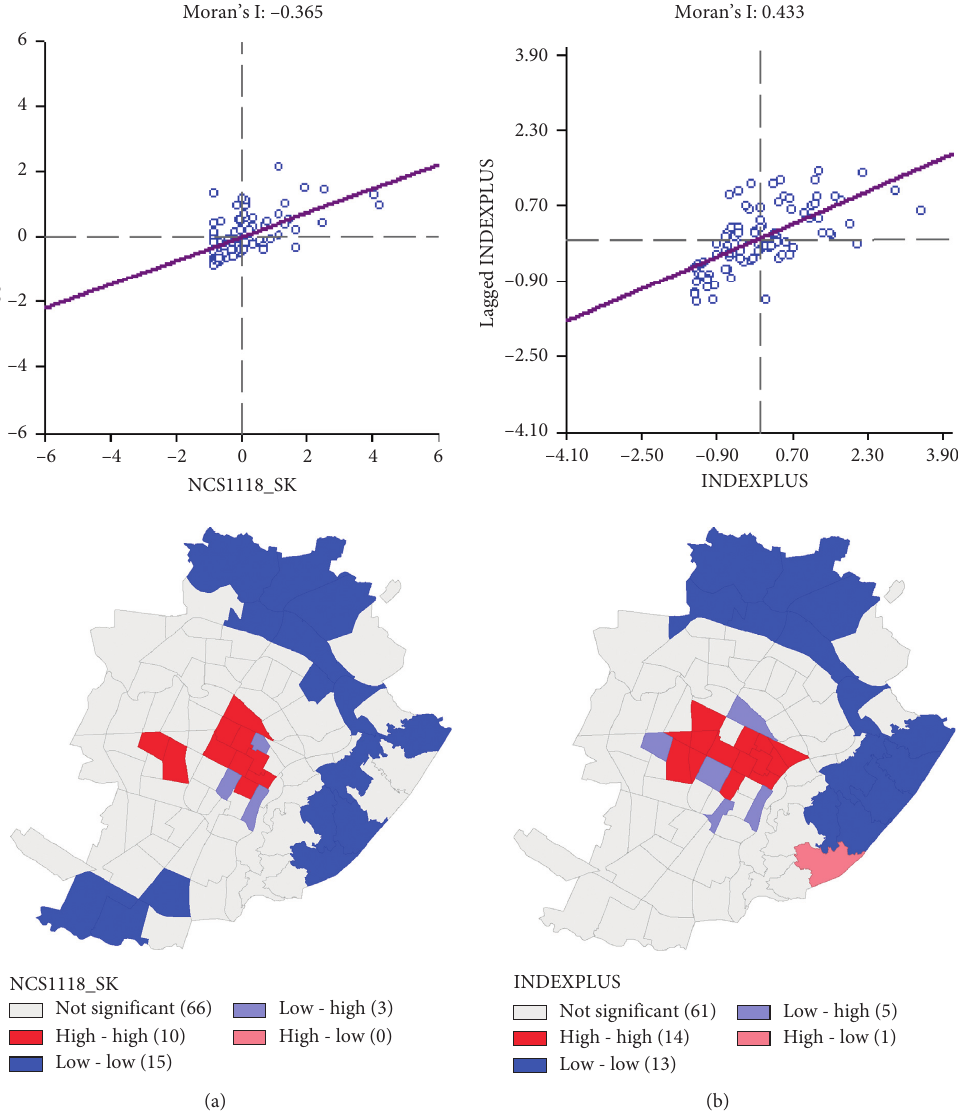
Figure 11: Moran’s Index scatterplot and Local Indicator of Spatial Association (LISA) cluster maps in the 94 SZ of Turin, depicting spatial clustering and spatial outliers: (a) CSD (n/km 2 ); (b) NeSI (source: authors’